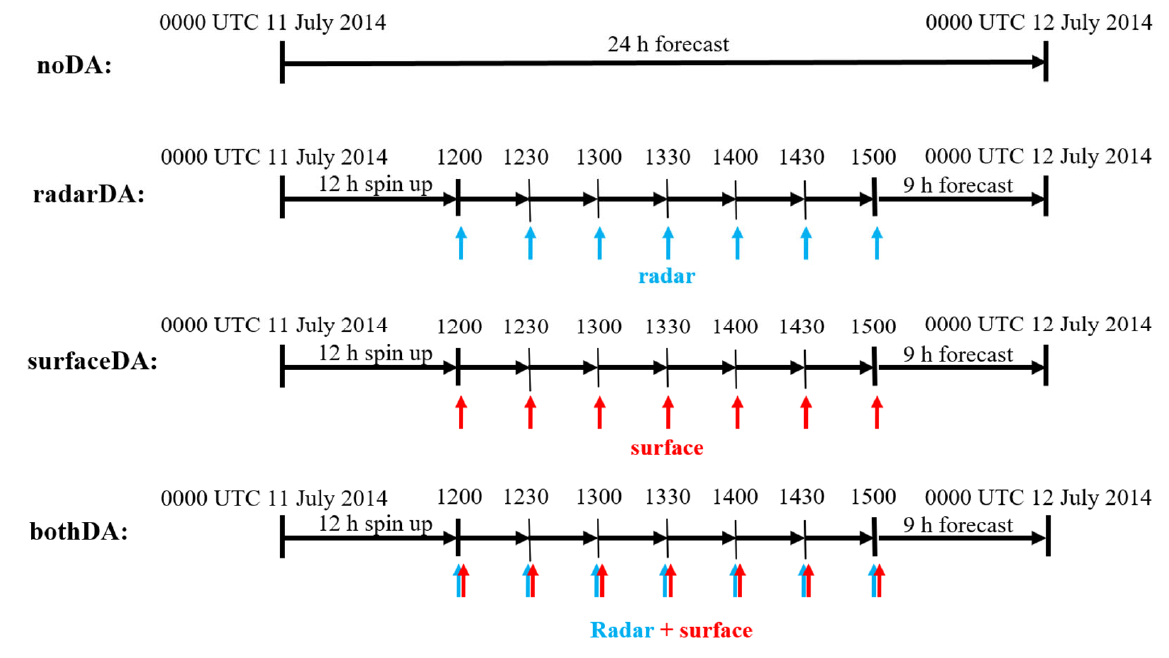
Figure 2. Flowchart for noDA, radarDA, surfaceDA and bothDA experiments.